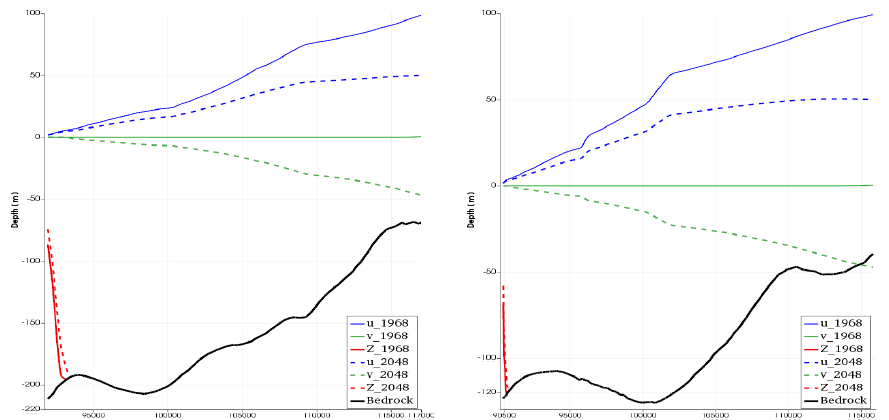
Figure 17. Vertical cross section showing the interface position (red line), the free surface position (blue line) and the variation of the saltwater hydraulic head (green line), for different times: cut on the levels 4 ( left ) and 5 ( right